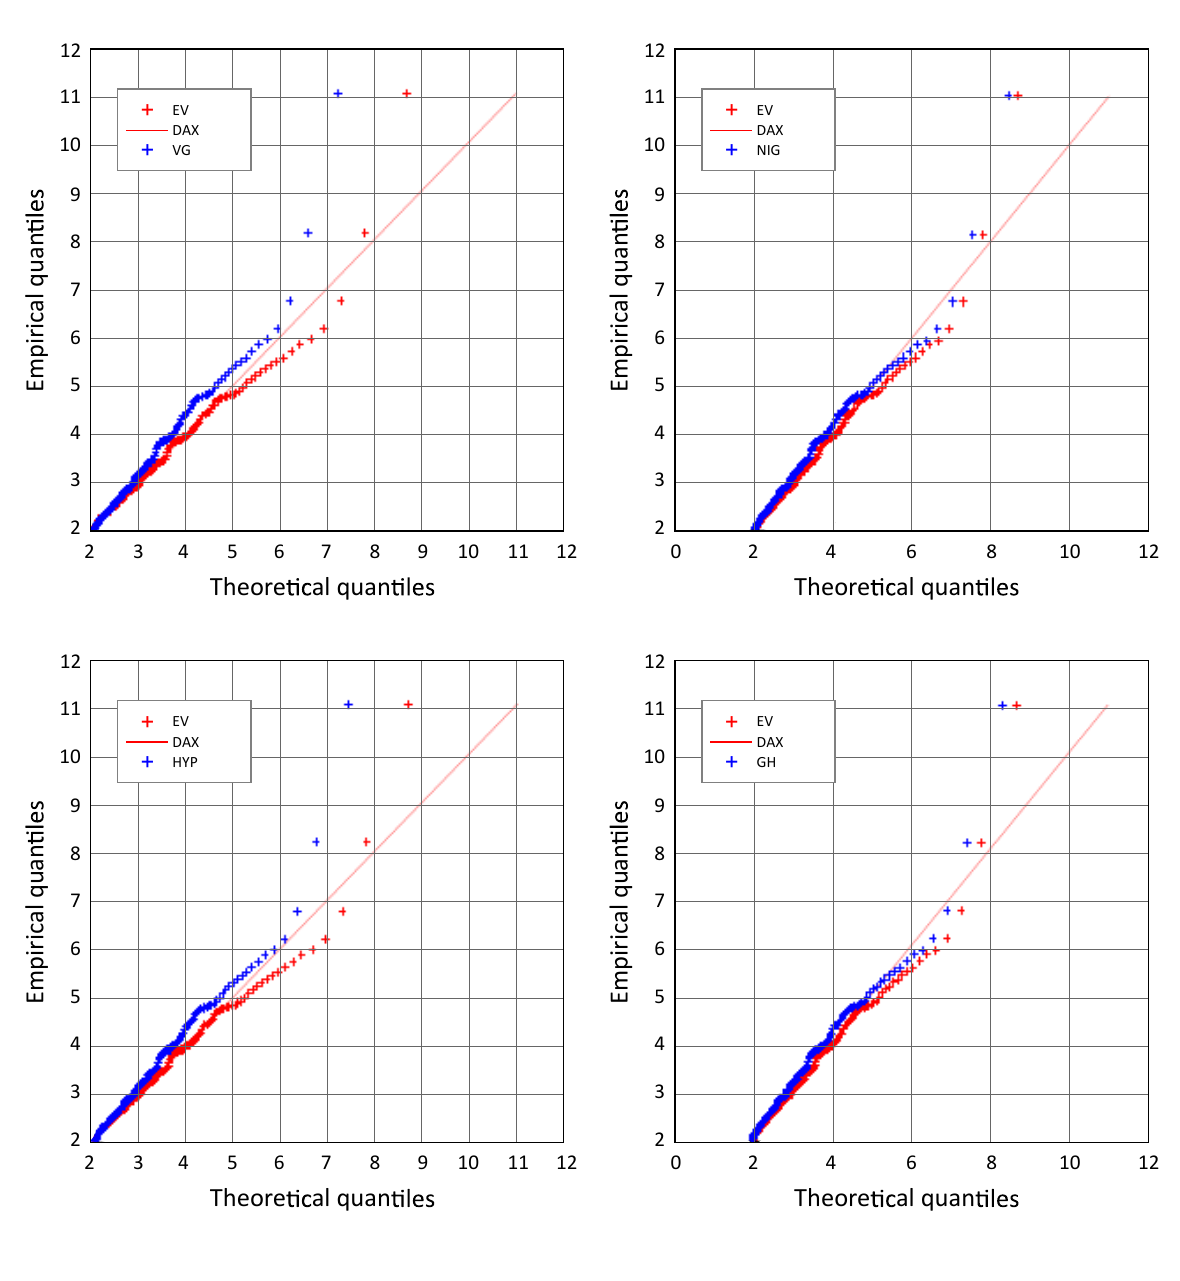
Figure 3. Conditional and unconditional quantiles in excess of threshold (2): long position in